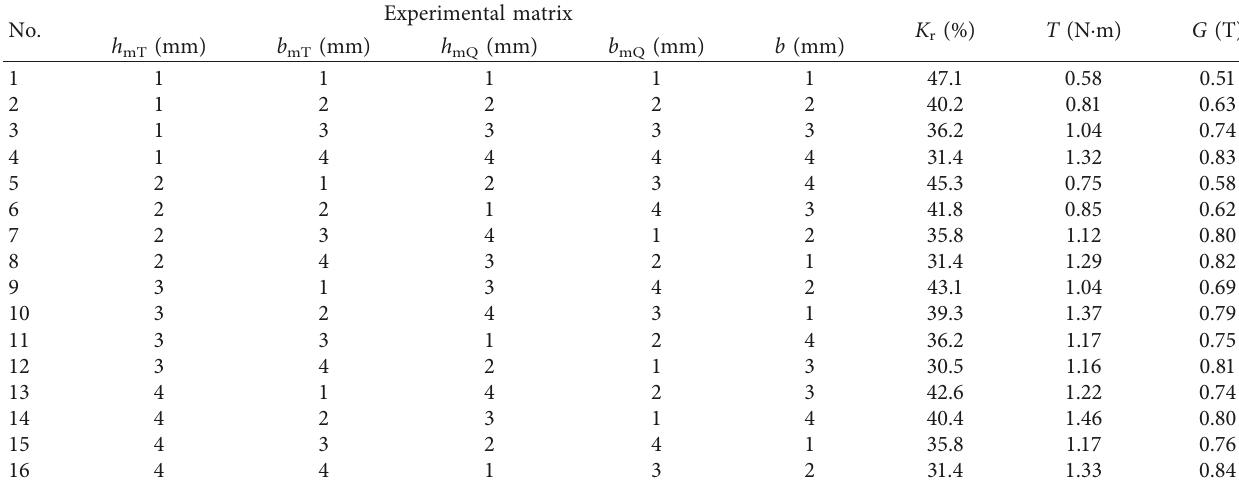
Table 3: Experimental matrix and finite element analysis.